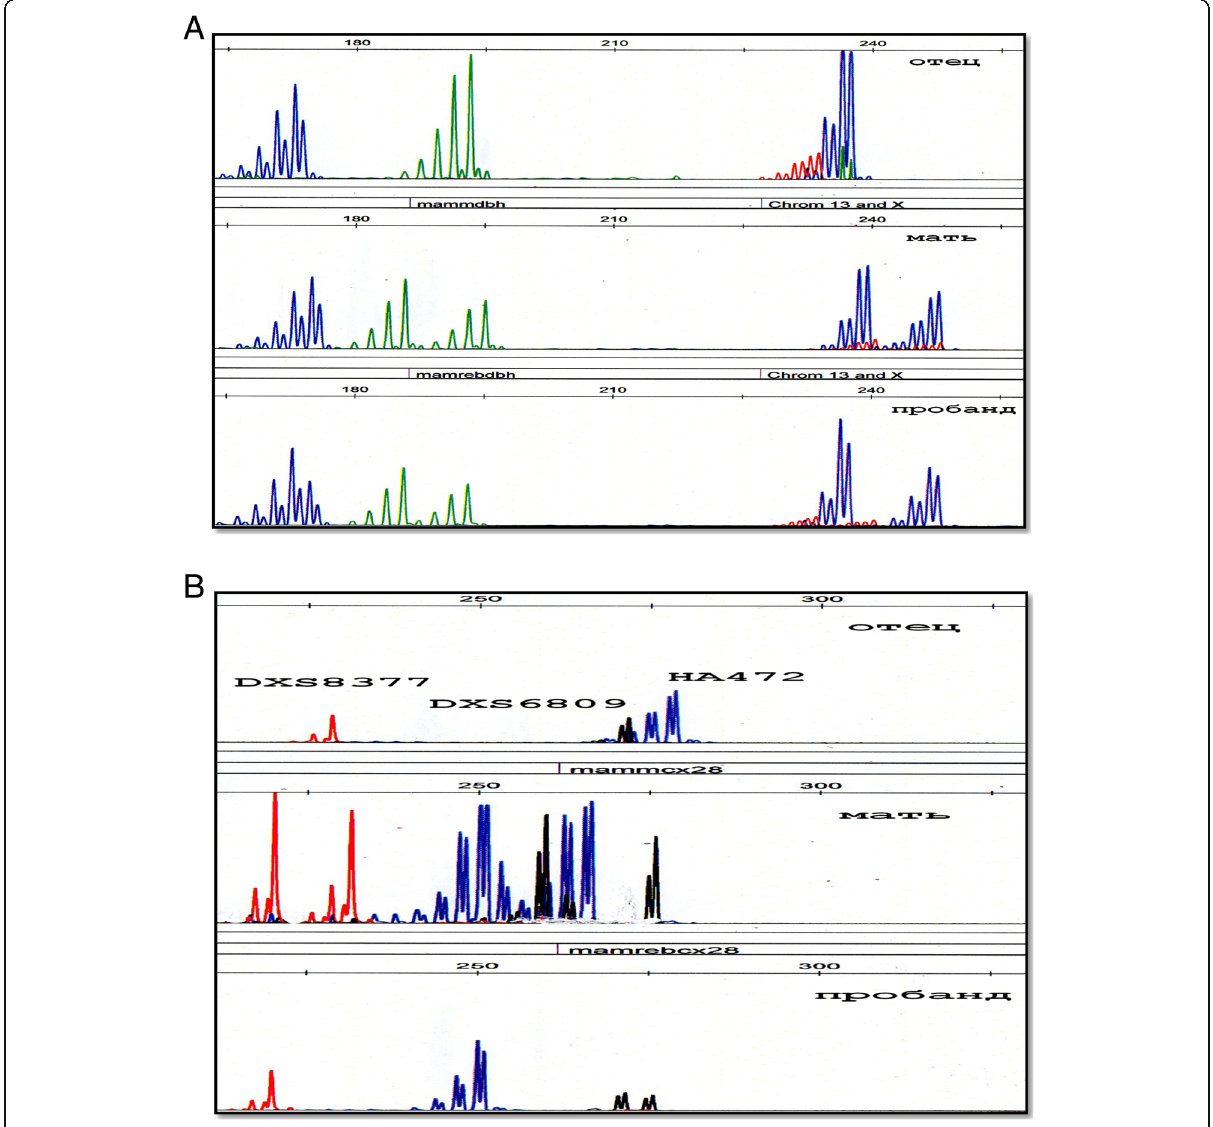
chromosome X is distal to